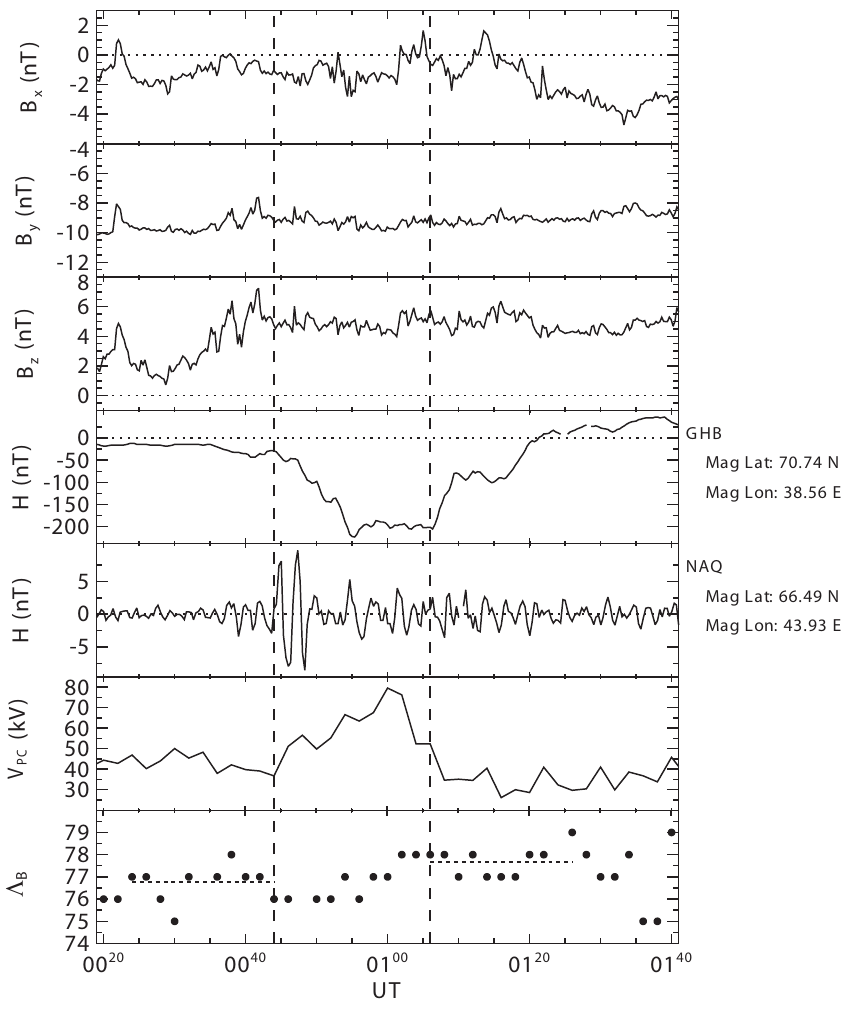
Fig. 8. Summary plot of the princi- pal observed substorm features. The top three panels show the IMF mea- surements by the ACE spacecraft in GSM coordinates, lagged by 74min as in Fig. 2a, shown for the interval 00:20–01:40UT on 2 December 1999. The fourth panel similarly shows the H -component of the magnetic field measured by the GHB magnetometer, while the fifth panel shows the H - component magnetic field band-pass filtered between 20 and 200s measured by the NAQ magnetometer. The sixth panel shows the total transpolar voltage V PC derived from SuperDARN radar data using the Map-Potential algorithm, while the seventh panel shows an esti- mate of the latitude of the flow rever- sal boundary on the dusk meridian, ob- tained from the minimum in the electro- static potential. The horizontal dashed lines show the location averaged over 20-min intervals before and after the substorm. The vertical dashed lines are as in Fig.